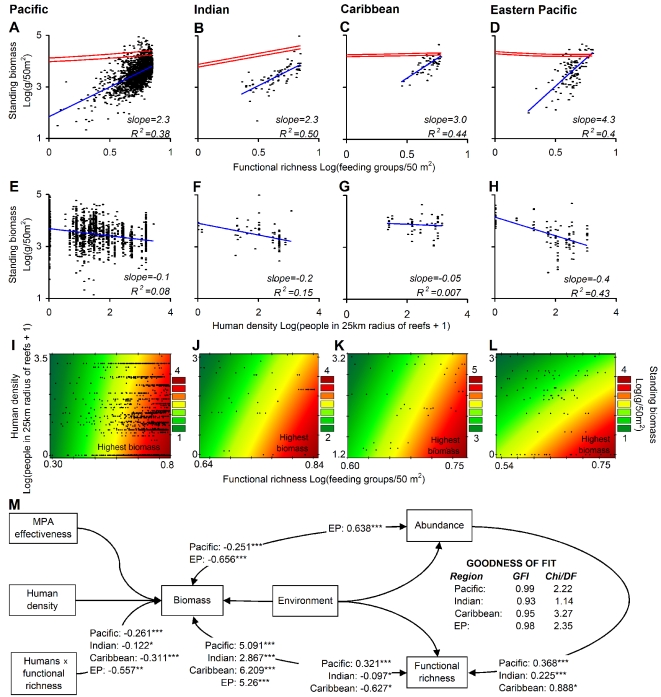
Predictors of standing biomass in reef fishes.(A–D) Plots showing the relationship between standing biomass and functional richness for each region. Plots are on a logarithmic scale because this produces better fit to the data (Table S3; see Figure S2 for plots with species richness and Figure S3 for plots controlling for abundance of individuals). Blue lines indicate the linear trend fitted to the data, while red lines indicate 95% confidence intervals around the mean trend line relating standing biomass and diversity as calculated from the null model described in the text (results based on 100 runs of such null model). (E–H) Plots depicting the relationship between standing biomass and human population density. (I–L) Plots outlining changes in standing biomass as calculated from estimates of its covariance with functional richness and human population density as predicted from the structural equation model shown in (M). Fitting the equation that predicts standing biomass from human population density and functional richness is superior to fitting a trend surface over the raw data, as the former accounts for other variables (Figure S5 shows fits to the raw data). Equations were fitted only over the range of values of the data collected, which are indicated with black dots. (M) Diagram showing the unstandardized covariance estimates for the relationships in the structural equation model run independently for each region. All variables were log-transformed. The goodness-of-fit metrics are shown inside (M). The best model for each region included the variables for which the unstandardized covariance estimates are shown. Statistical significance for all relationships is best assessed from the results of the structural equation model given the control of confounding factors. Significance of covariance estimates with critical ratios significant at p<0.0001 (***), p<0.001 (**), and p<0.01 (*) are indicated beside each estimate. Chi/DF, Chi-square divided by the degrees of freedom; EP, Eastern Pacific; GFI, goodness-of-fit index.